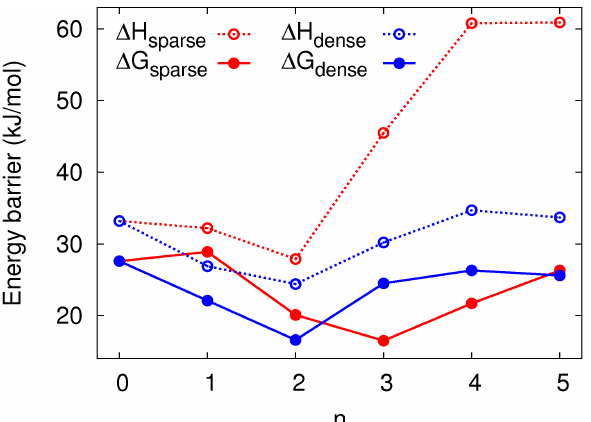
Fig. 5. 1H and 1G of the two classes of transition states as func- tion of number of water molecules, n , at standard conditions. The structures of the “dense” and “sparse” transition states are shown in Figs. 4 and 6, respectively. The barrier of the charge neutral reac- tion is at least 58kJmol − 1 for n = 0. The values are tabulated in the